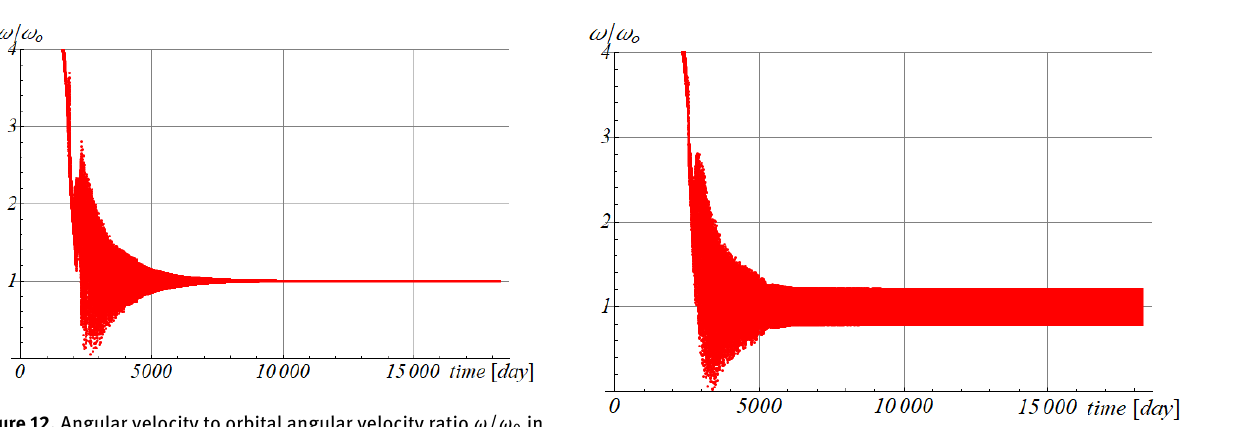
Figure 12. Angular velocity to orbital angular velocity ratio ω / ω 0 in case of gravitational stabilization final regime.